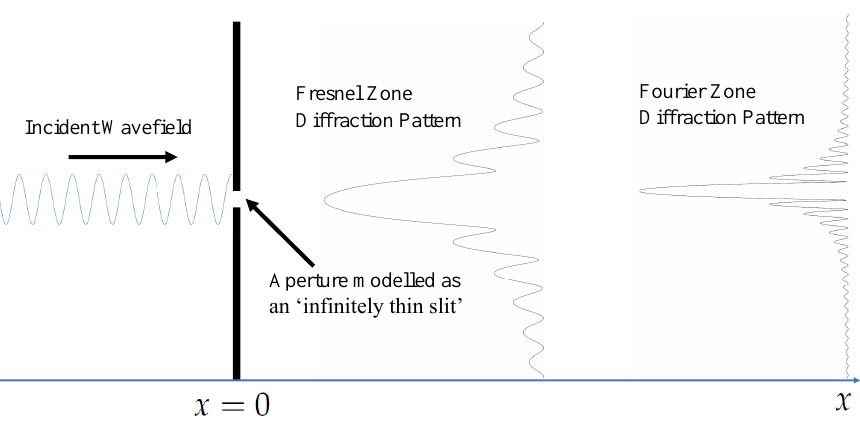
Figure 2. Examples of intensity diffraction patterns given by Equations (38) and (39) in the (two- dimensional) Fresnel and the Fourier zones generated by the scattering of a plane wave propagating through and interacting with a single (infinitely thin) aperture as illustrated—not to